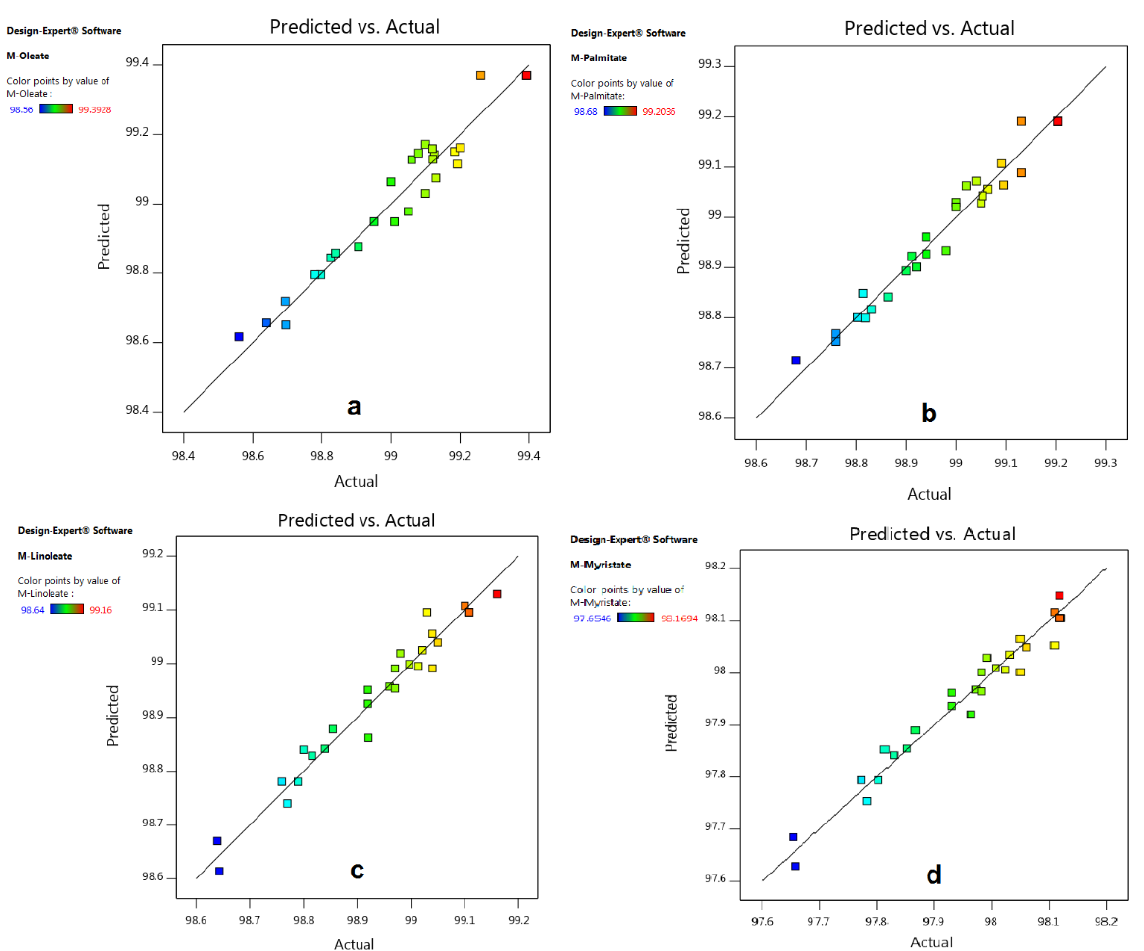
Figure A3. Predicted versus actual values for methyl-oleate model ( a ), methyl-palmitate model ( b ), methyl-linoleate model ( c ) and methyl-myristate model ( d ).